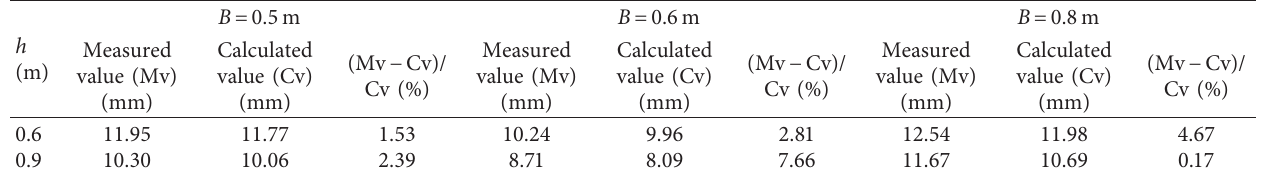
Table 5: (a) when the buried depth h � 1.2 m, the maximum